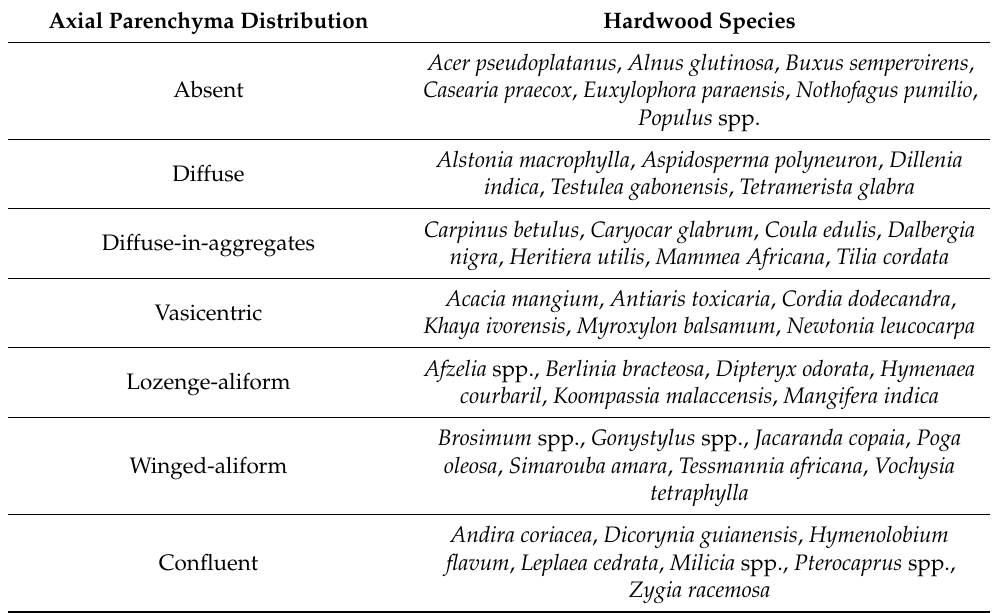
Table 10. Examples of species for different types of axial parenchyma distribution in hardwoods. Axial Parenchyma